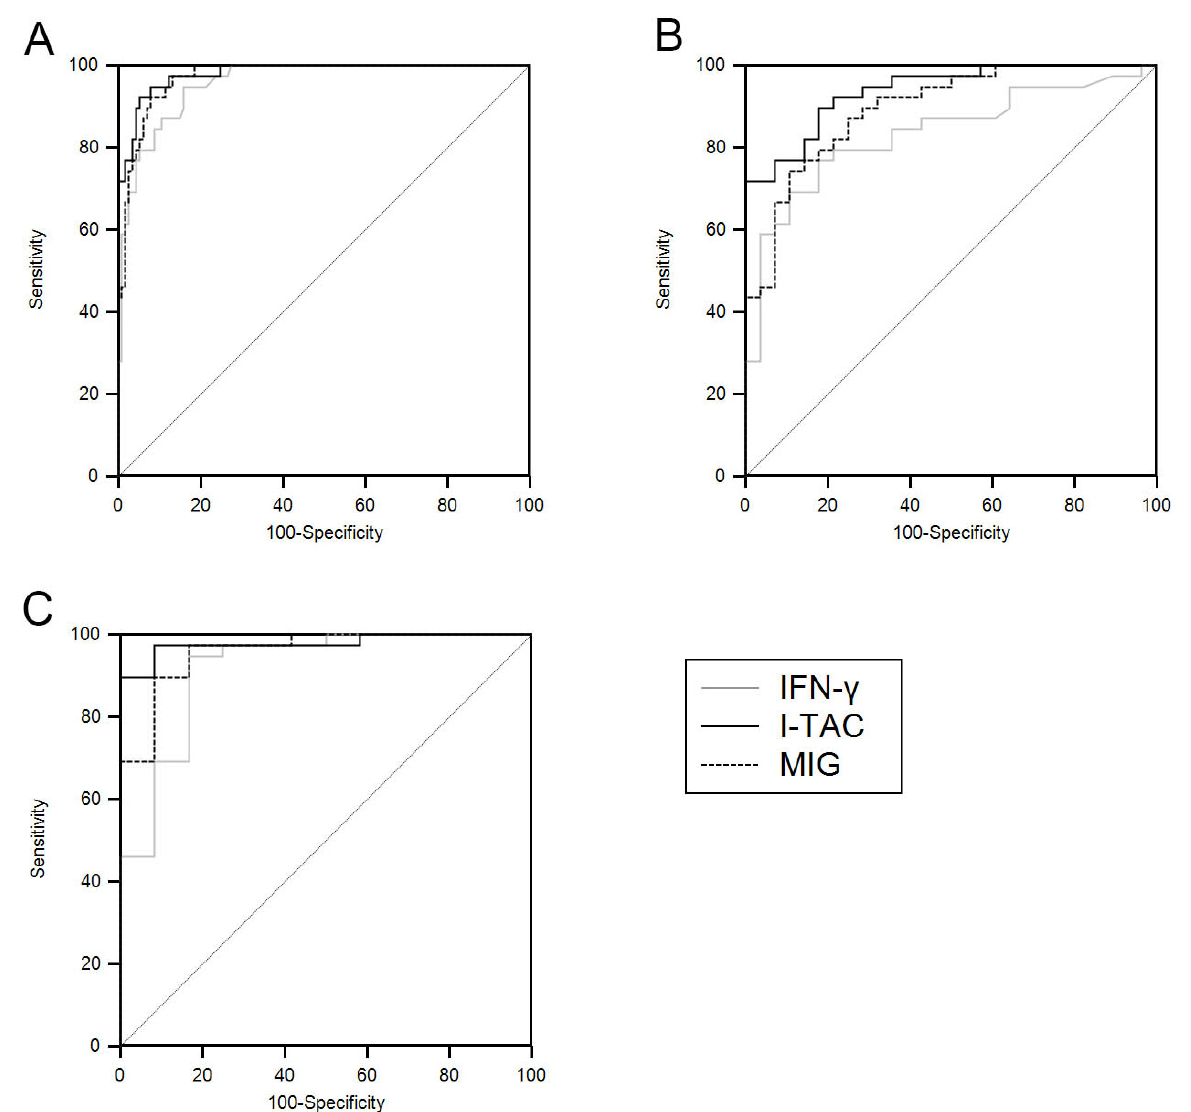
Figure 5. Receiver operating characteristic curves of interferon (IFN)- γ , IFN-inducible T-cell α –chemoattractant (I-TAC), and monokine induced by IFN- γ (MIG) for differentiating definite tuberculous lymphadenitis patients from the controls ( A ), IFN- γ release assay-positive controls ( B ), and patients with non-tuberculous lymphadenitis ( C ).